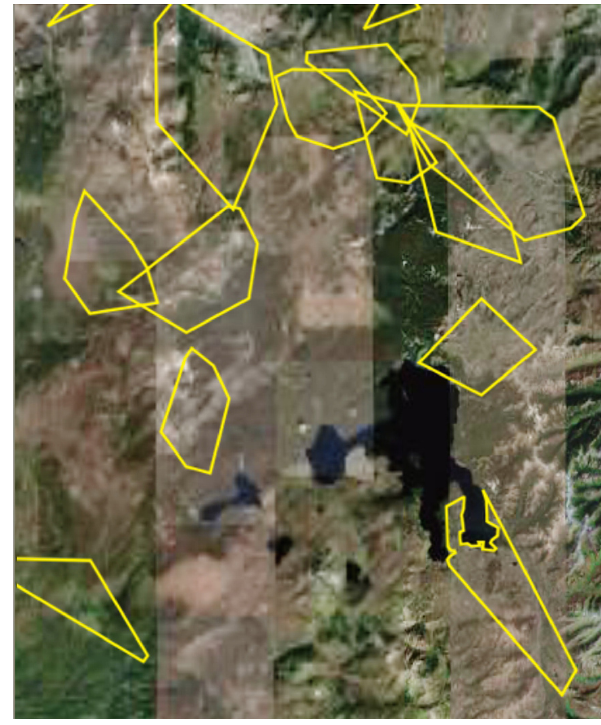
Figure 3. Wolf pack territories have boundaries (year 2004) that ex- tend over different habitats and thus ignore the majority of habitat discontinuities. Territories may also overlap and boundaries inter- sect. This case illustrates that a search for “visible” or pattern-based boundaries has conceptual weaknesses and practicalities. Map of territories adapted from http://www.nps.gov/features/yell/slidefile/